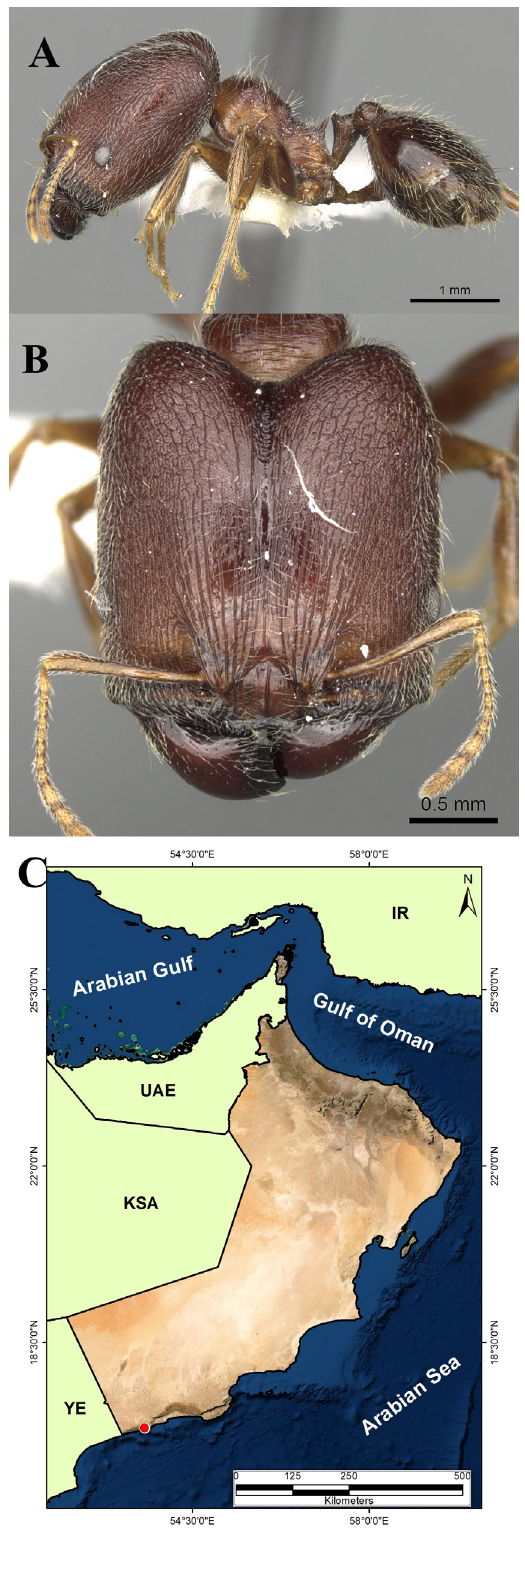
Fig. 46. Pheidole sculpturata Mayr, 1866, major worker (CASENT0281616, AntWeb.org (Shannon Hartman)). A . Body in profile. B . Head in full-face view. C . Distribution